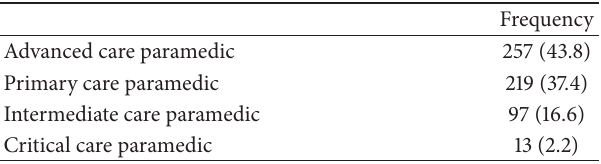
Table 1: Paramedic certification